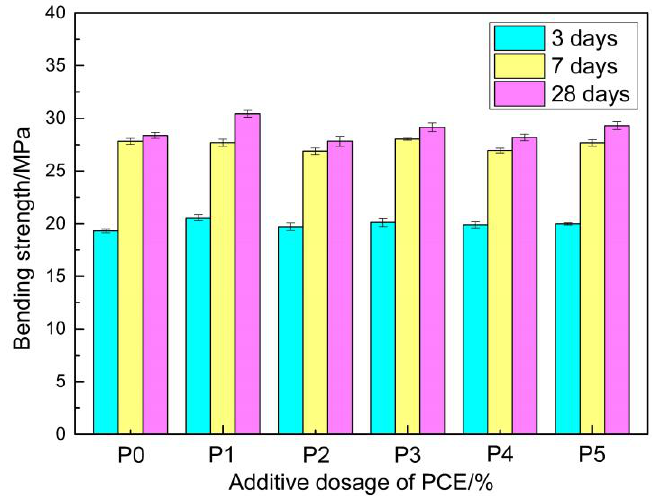
Figure 7. Bending strength of samples with different ratios of PCE.